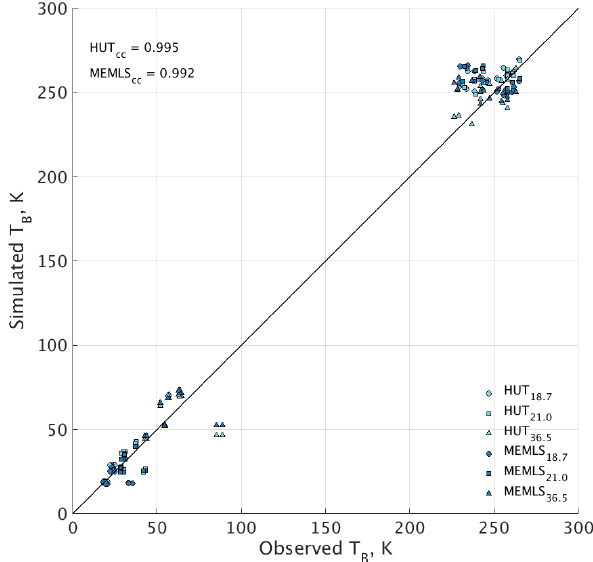
Figure 4. HUT (light blue) and MEMLS (dark blue) simulated brightness temperatures plotted against observed brightness temper- atures at 18.7 (circle), 21.0 (square), and 36.5GHz (triangle). The correlation coefficients of the single-layer HUT model (HUT CC ) and MEMLS (MEMLS CC ) are also